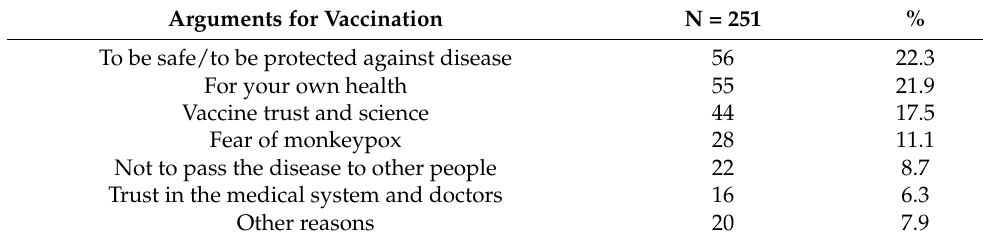
Table 6. Arguments of participants who accept vaccination against monkeypox.